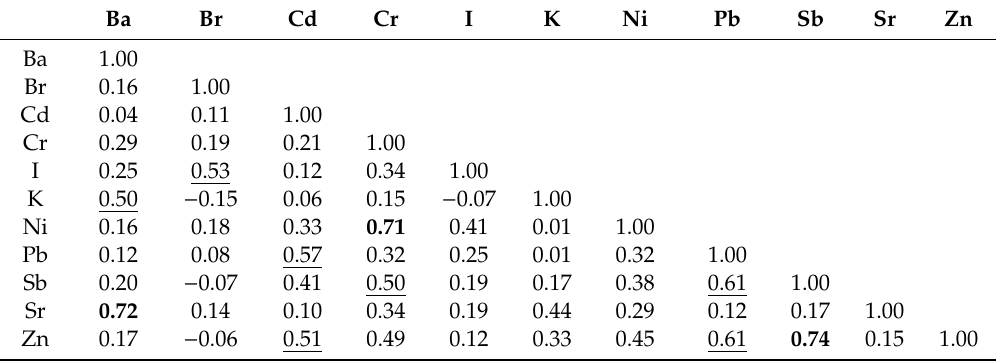
Table A2. Matrix of correlation coe ffi cient ( n = 216), a group of 11 selected elements, natural and anthropogenic